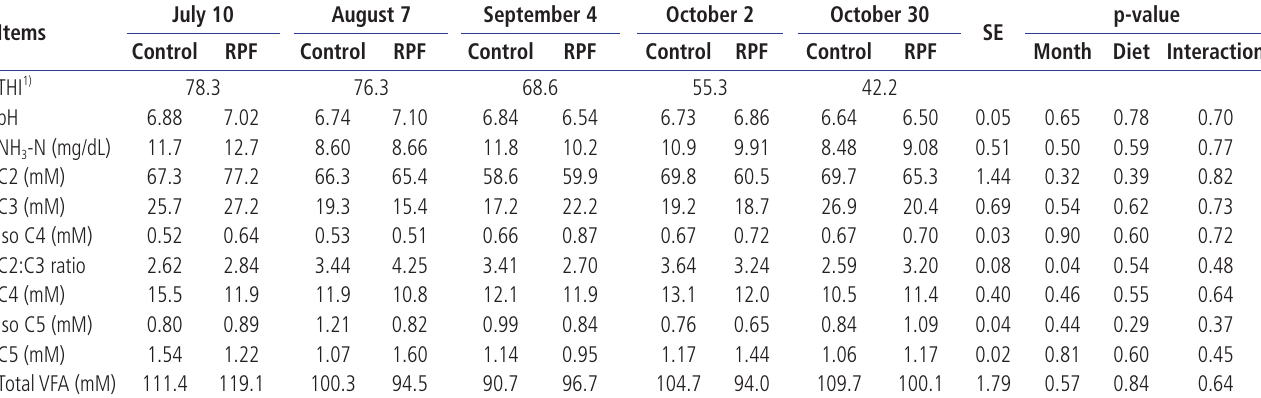
Table 4. Ruminal pH, VFAs and NH -N of Korean cattle steers fed either control or RPF-supplemented diet during July through October of 2015 (after 3 h of feeding) 3